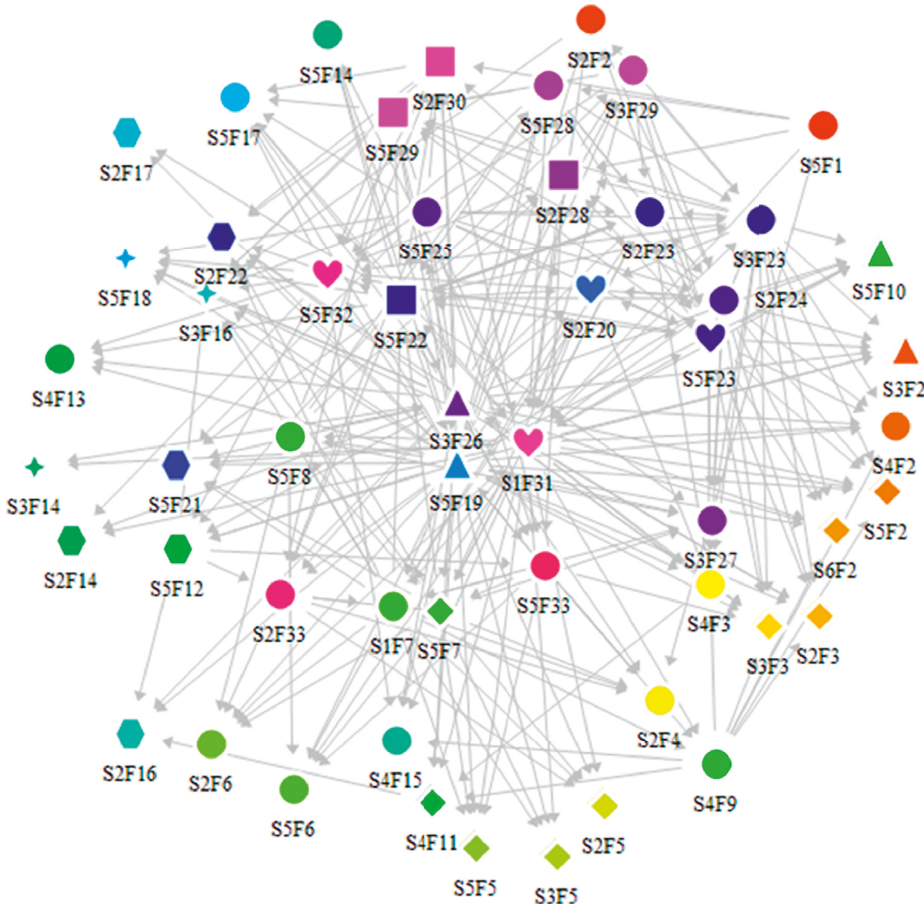
Figure 3: Stakeholder-related influencing factor